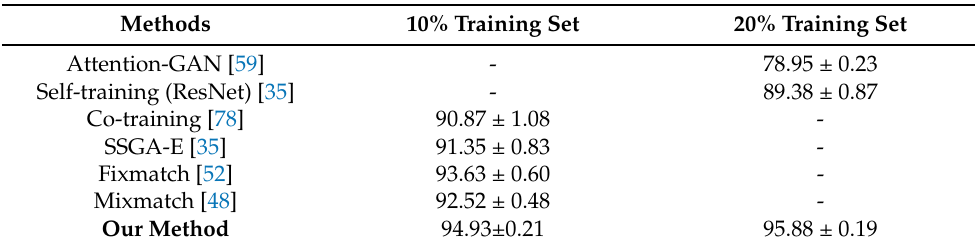
Table 4. Overall accuracy and standard deviations (%) of the proposed method and comparison methods on the AID dataset.